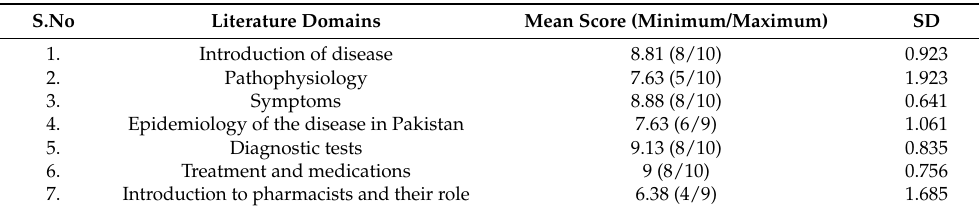
Table 1. Patient feedback.